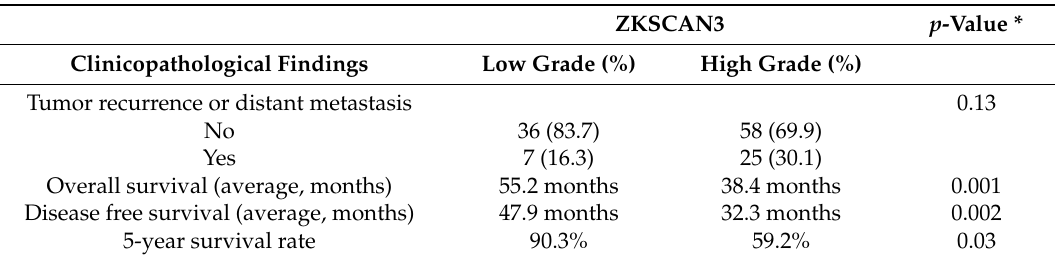
Table 3. Multivariate analysis of clinicopathological prognostic factors in the patients with uterine cervical cancer.